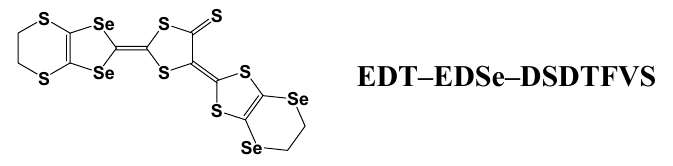
Figure 16. SEM images of (a and b) bundle and (c) single micro/nano-wires